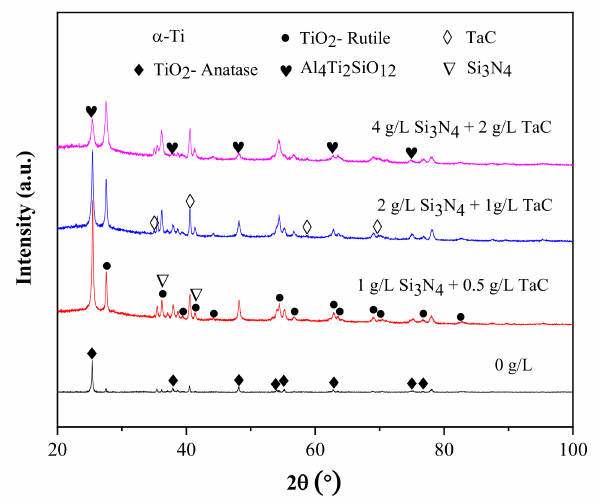
Figure 5. XRD patterns of the MAO coatings with different concentration of Si 3 N 4 /TaC particles. This indicated that the Si 3 N 4 particles were partially reactively incorporated into the composite MAO coatings, which was inconsistent with the results from Lu et al.